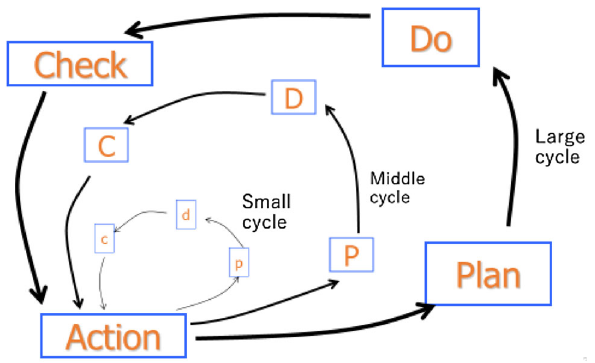
Fig. 2 Nested structure of the Plan-Do-Check-Action (PDCA) pro- cess designed to evolve spirally